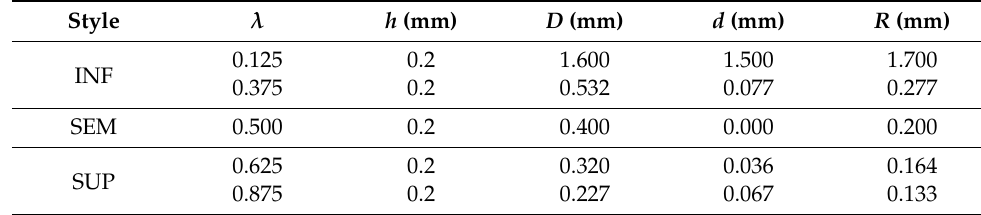
Table 2. Geometric parameters of